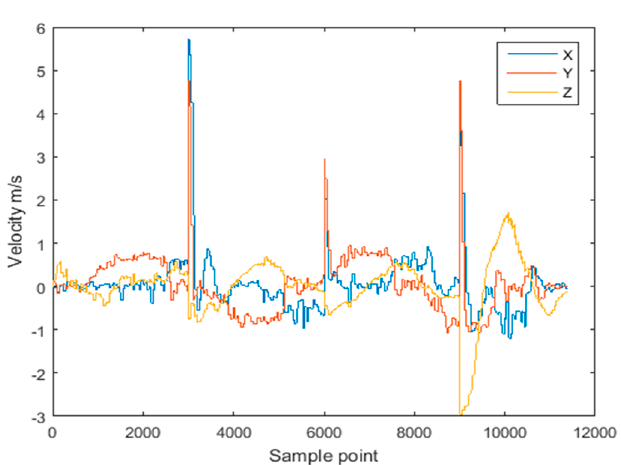
Figure 9. Velocity for Route 1.